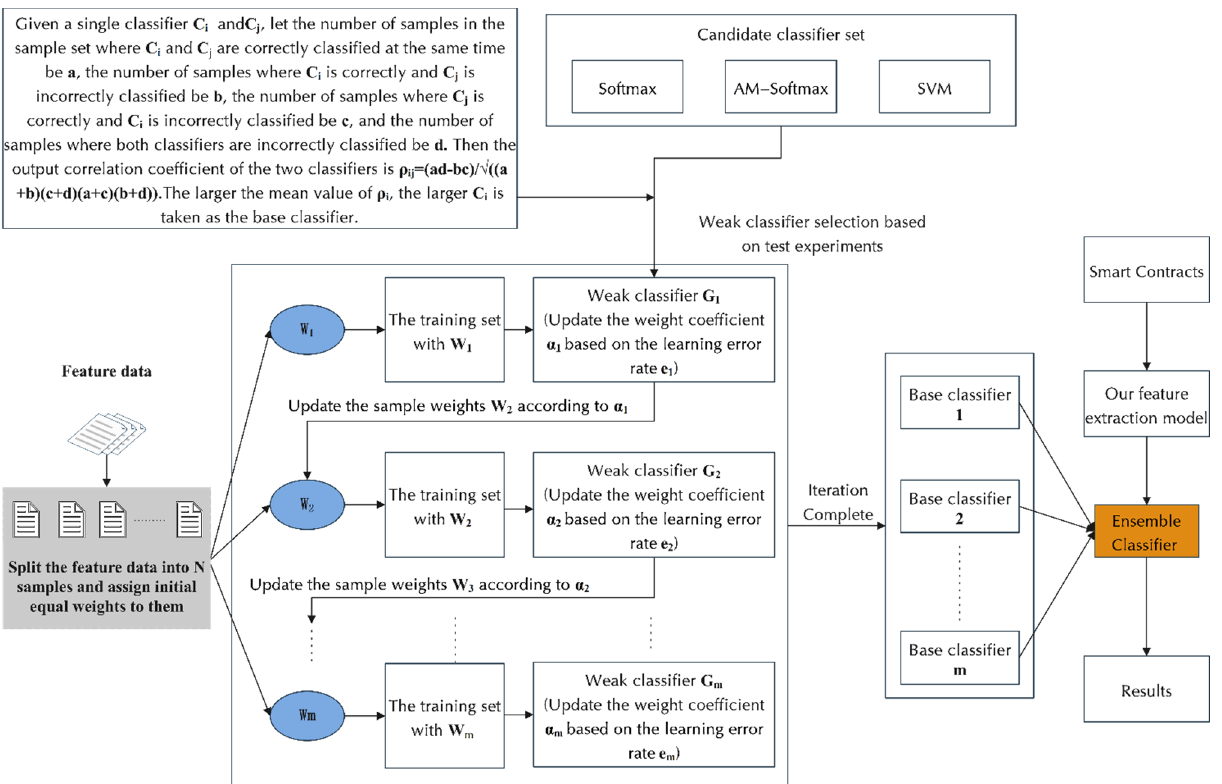
Algorithm 1 Integration Algorithm to Implement Ensemble Classifier